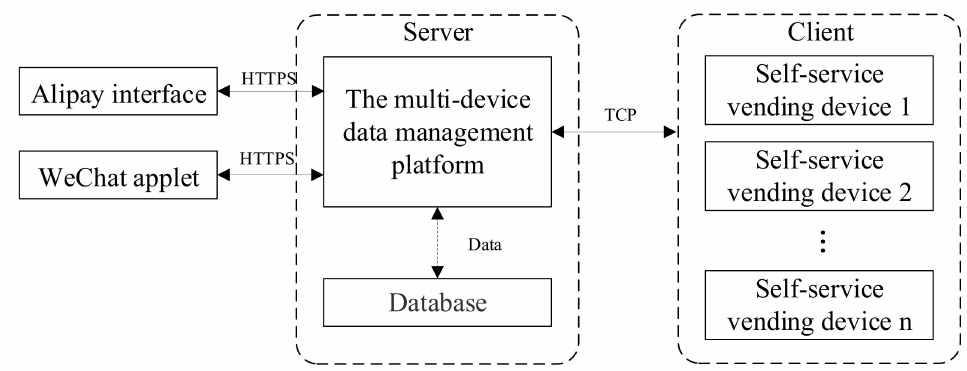
Figure 11. The flow of information inside the IoT